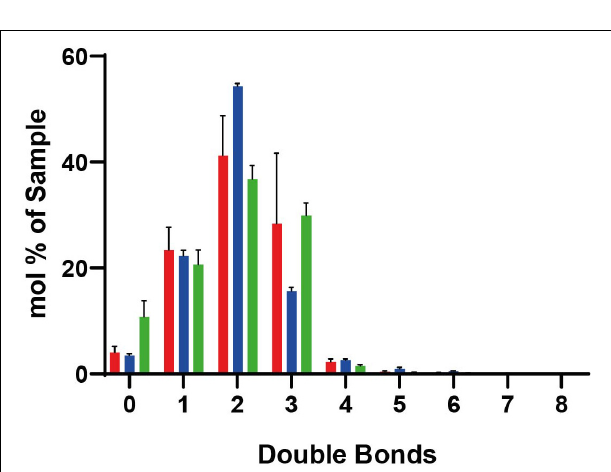
FIGURE 6 | Lipidomic data for lipids with different numbers of double bounds. In peroxisomes (red), mitochondria (blue), and ER (green). Standard deviations result from the three different measurements. Mole percentages of the total amount of lipids are shown on the y -axis (sum amount of a lipid species with the same double bond count divided by the total amount in the sample, multiplied by